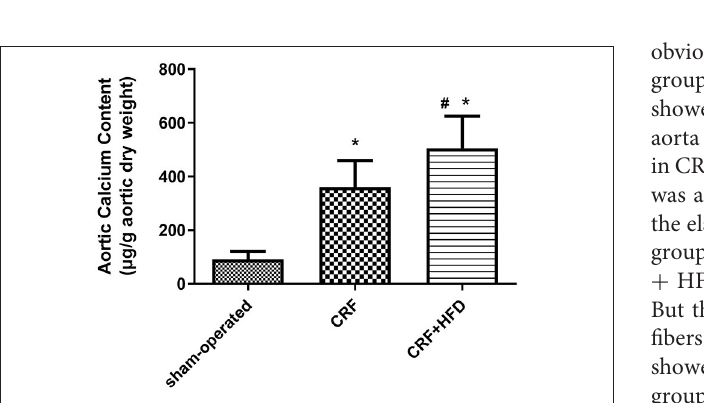
FIGURE 2 | Comparison of calcium content in the aorta of rats in each group. Six rats were included in each group. * P < 0.05 vs. sham-operated group; # P < 0.05 vs. CRF group. CRF, chronic renal failure; HFD, high fat